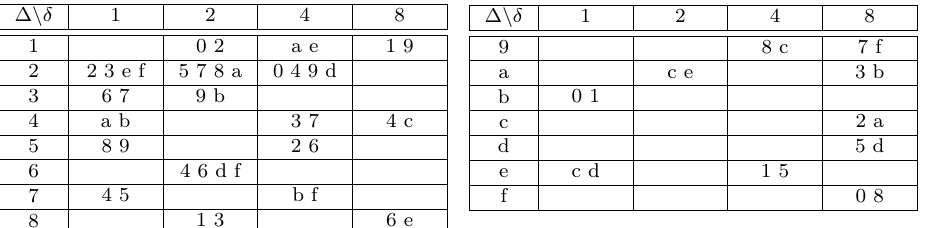
Table lookup for Sbox . Sbox (substitution-box) is a basic nonlinear component in cipher designs, mostly used in SPN (Substitution-Permutation Network) ciphers. Sbox is responsible for the confusion property in encryption modules defined by Shannon